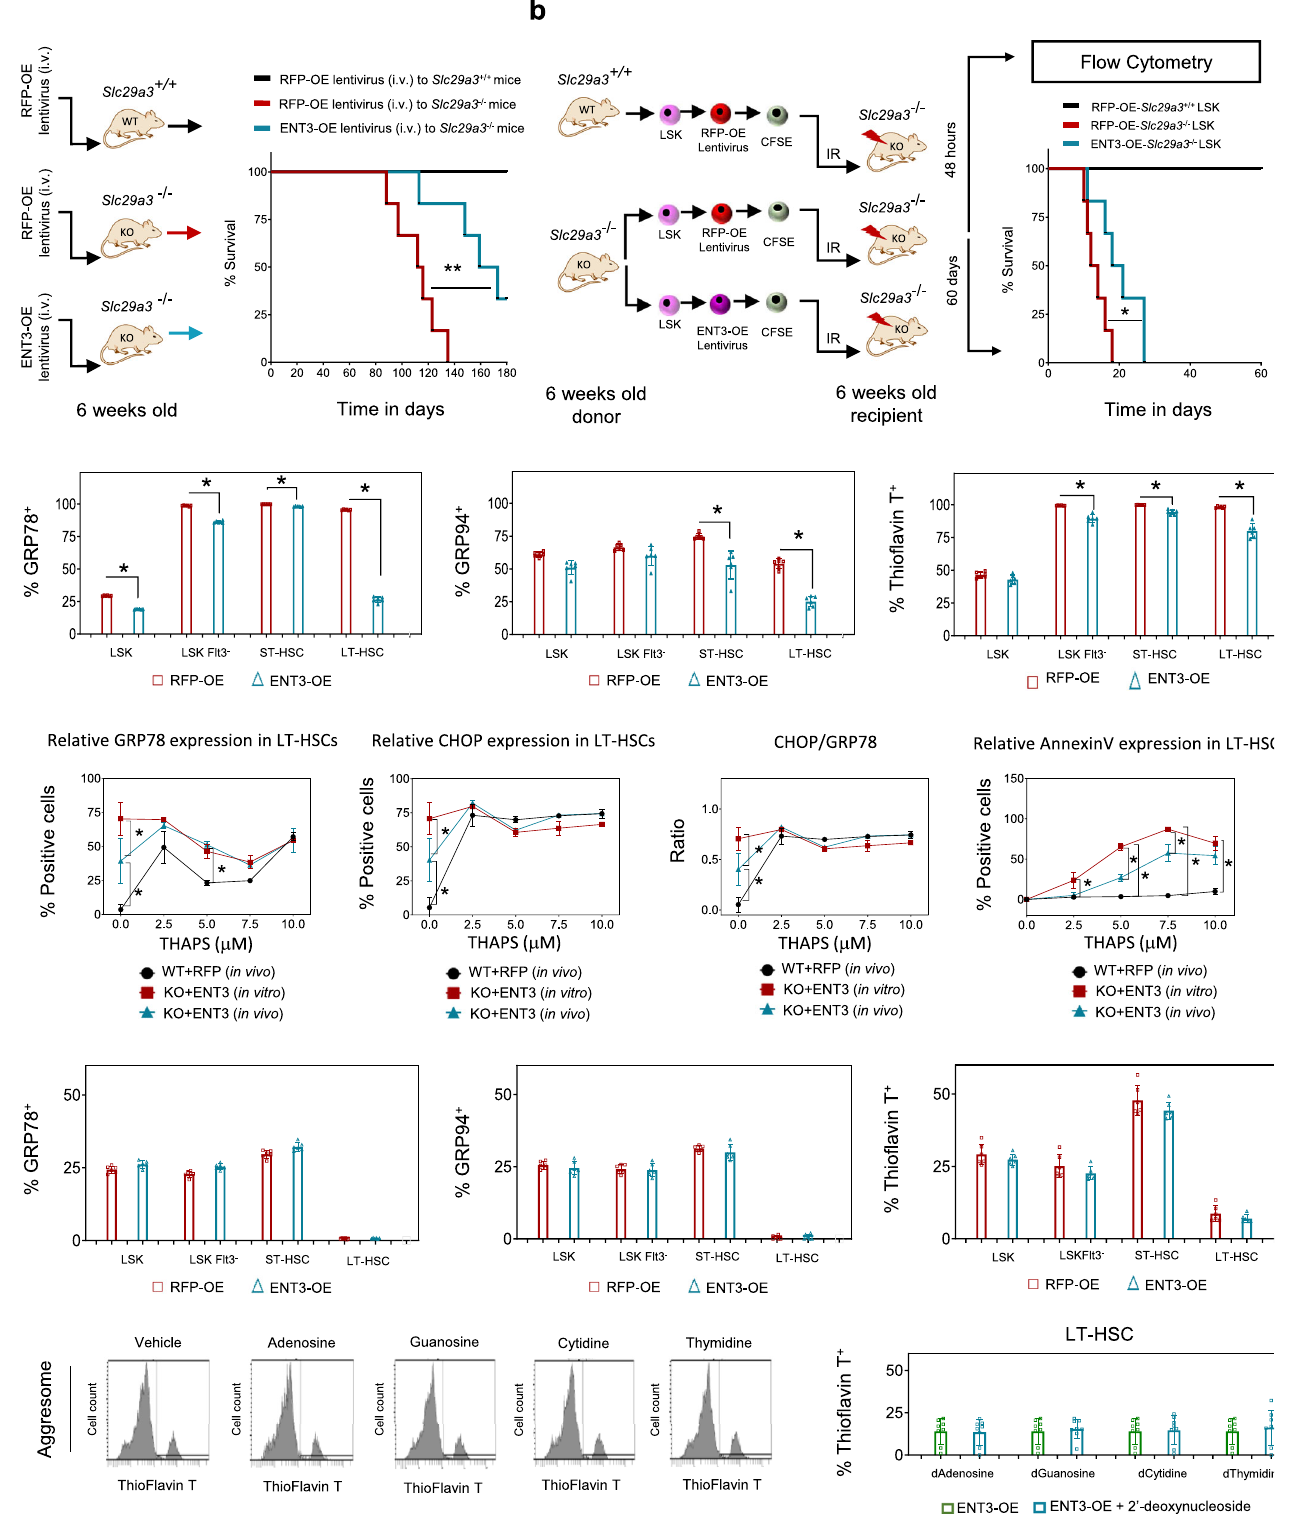
oocyte assay using tritiated ( 3 H)-CA and 3 H-DCA as substrates (Fig. S13); we found a high correlation between both assays ( r 2 = 0.89). Kinetic analysis showed that BA fl ux in ENT3 injected oocytes (corrected for basal uptake in water-injected oocytes) was saturable and conformed to simple Michaelis – Menten kinetics (CA, V max : 3.07 ± 0.04 pmol/30 min/oocyte, K m : 167.5 ± 13.3